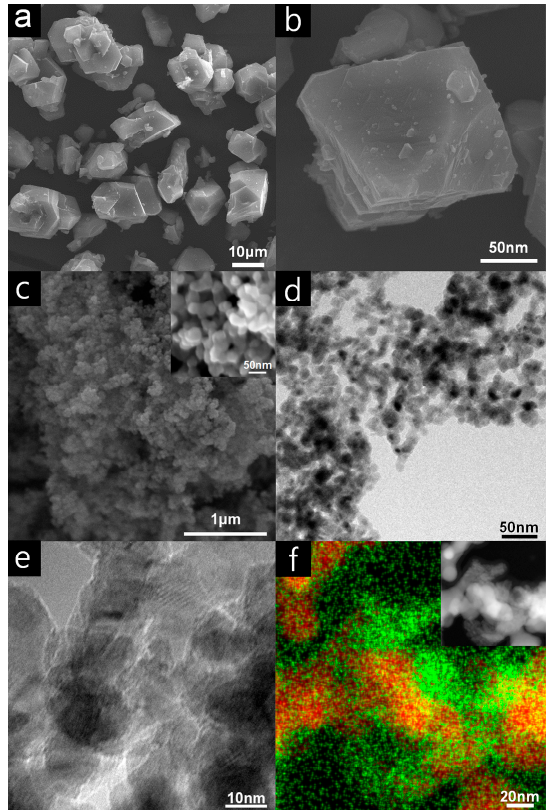
Figure 1. ( a , b ) SEM images of Cu(II)-MOF; ( c ) SEM and FE-SEM (inset) images of Cu@Cu 2 O core-shell nanocatalyst and ( d , e ) TEM images of Cu@Cu 2 O core-shell nanocatalyst; ( f ) elemental mapping and HAADF-STEM image (inset) of Cu@Cu 2 O core-shell nanocatalyst (red for copper, green for oxygen). The Fourier transform infrared (FT-IR) spectrum and powder X-ray diffraction (XRD) pattern were acquired to verify the formation of Cu(II)-MOF and Cu@Cu 2 O. The FT-IR spectrum of Cu(II)-MOF in Figure 2a shows absorption peaks near 480 and 730 cm − 1 that can be assigned to the characteristic Cu–O stretching vibration. The characteristic peaks near 1110, 1380 and 1640 cm − 1 are attributed to Figure 2b shows very sharp diffraction peaks at 11.56 ◦ , 13.39 ◦ , 14.64 ◦ , 15.01 ◦ , 16.42 ◦ , 17.44 ◦ , and 19.04 ◦ , corresponding to the (222), (400), (331), (420), (422), (333), and (440) crystalline planes of Cu(II)-MOF. Figure 2c shows that the XRD pattern of Cu@Cu 2 O core-shell nanocatalyst is consistent with the reference data for Cu and Cu 2 O. The crystalline size and shell thickness of Cu (111) and Cu 2 O (111) calculated from XRD data are 13.5 nm and 5.07 nm, respectively. And the Cu/Cu 2 O ratio was calculated from ICP and elemental analysis data and the ratio was confirmed as 1:0.8. The presence of copper and oxygen as the main elements was confirmed by ICP and elemental analysis data, and the Cu/Cu 2 O ratio was 1:0.8 which was calculated based on the amount of